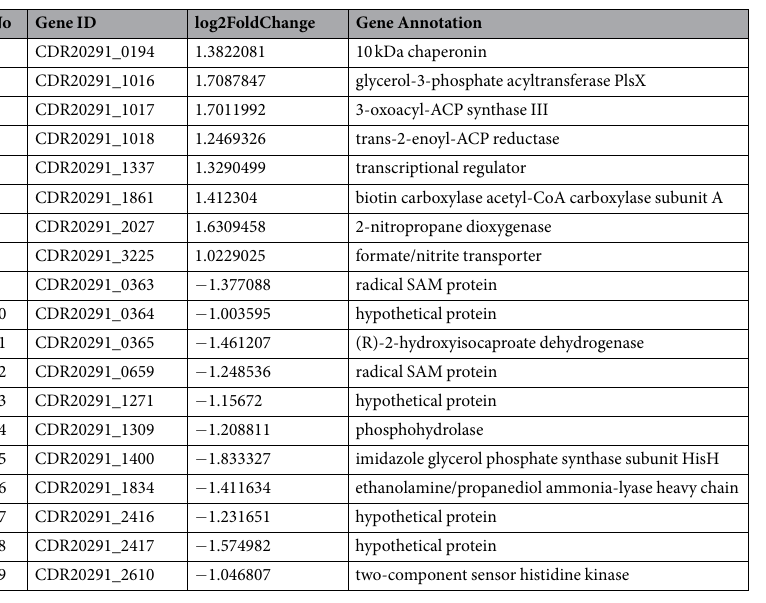
Table 2. Genes up and down-regulated in WT during co-culture with B . fragilis relative to the WT C . difficile monoculture. Note: P-adjusted value ≤